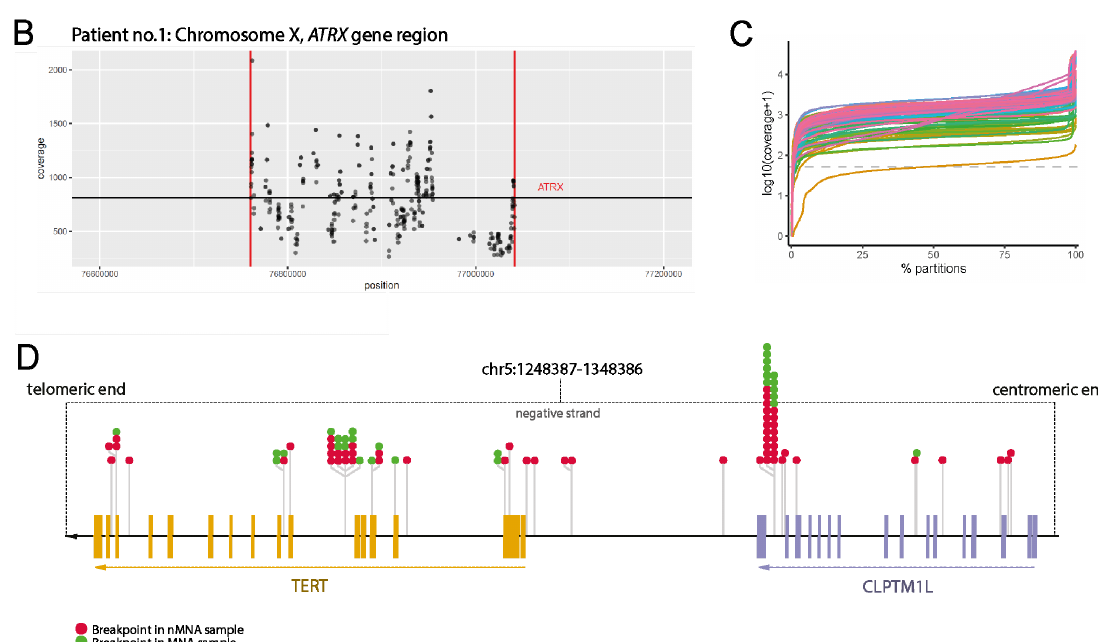
Figure 3. ( A ) Oncoplot of the cohort of routine samples displaying covariates and alterations detected with the NB-HCPS assay. Mutations marked by stars (*) are highly likely to be involved in cancers (Tier 1), as reported in the Catalogue of Somatic Mutations in Cancer (COSMIC, Release v92). ( B ) Example of partial ATRX loss detected in patient 1. ( C ) Sequencing coverage obtained with the NB-HCPS assay in samples of the routine cohort. ( D ) Distribution of breakpoints involved in the detected TERT